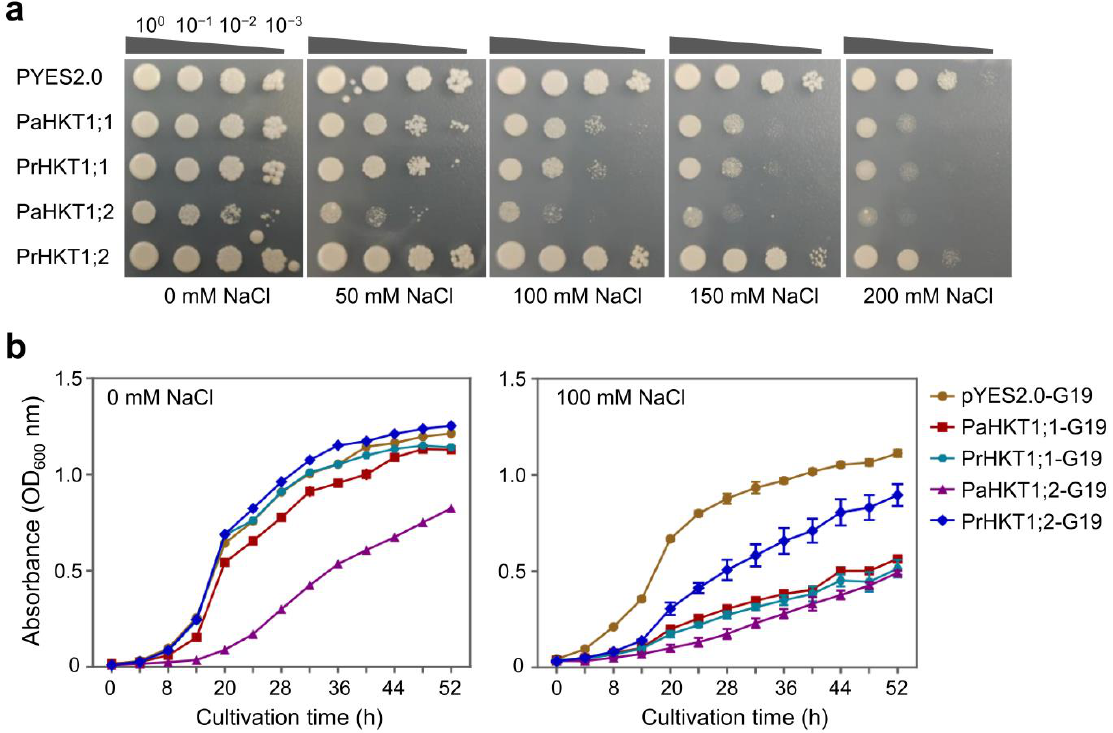
Figure 8. Difference in the Na + transport function of the HKT1;1 and HKT1;2 in P. alba and P. russkii . ( a ) Yeast mutant G19 complementary analysis of the Na + transport function of PaHKT1;1, PrHKT1;1, PaHKT1;2, and PrHKT1;2. ( b ) Yeast growth curve of the transformants of PaHKT1;1, PrHKT1;1, PaHKT1;2, and PrHKT1;2 to G19 in medium with 100 mM NaCl or without NaCl. Table 1. Effects of pharmacological treatments on low-affinity Na + influx in Populus plants under 100 mM NaCl. Na + concentrations were measured before treatments and after NaCl and inhibitor treatments for 24 h (each treatment had three biological replicates). Measurements significantly different from the control are indicated with a *, p < 0.05 ( t -test). Values represent mean ± SD (n = 3).